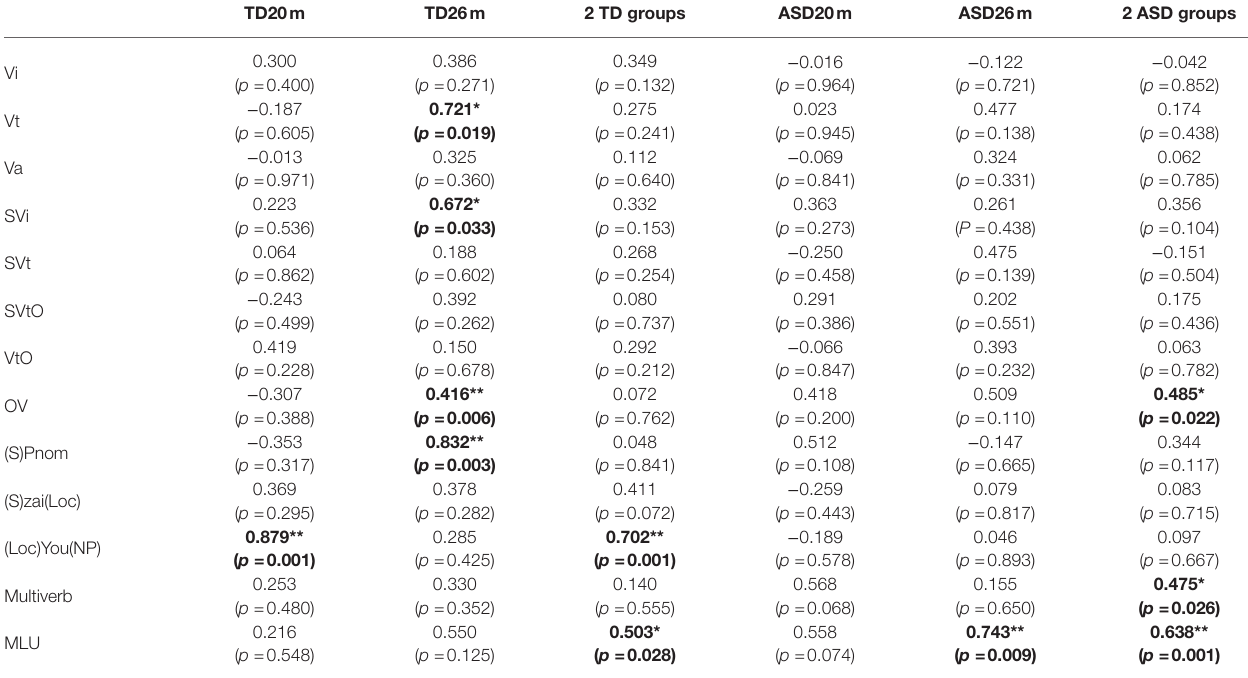
TABLE 9 | Correlations of word order uses between caregivers and children ( r values, p values). TD20 m TD26